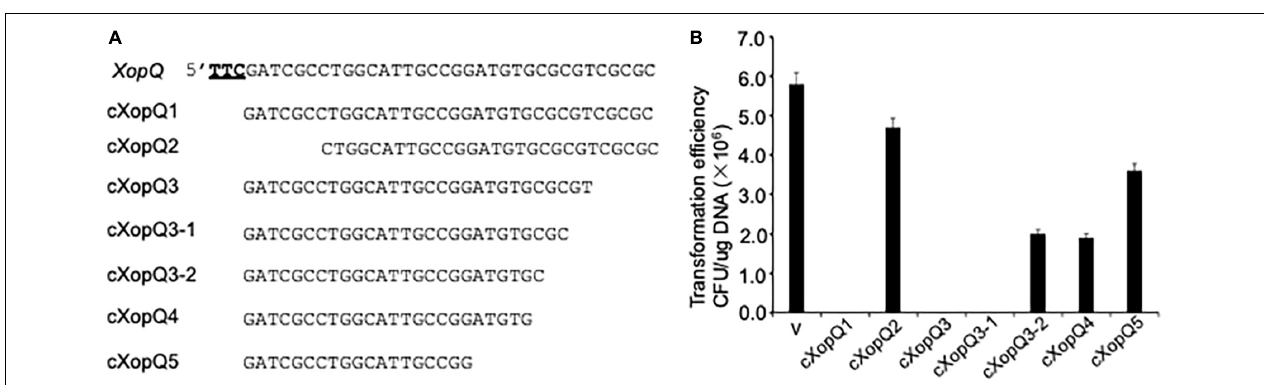
FIGURE 2 | Detection of CRISPR function using various truncated forms of gRNA spacer sequences. (A) gRNA sequence targeting spectinomycin gene as a native version (cXopQ1). Various truncated spacer sequences of gRNA missing either their 5 (cid:48) sequences or their 3 (cid:48) sequences (cXopQ2, cXopQ3, cXopQ3–1, cXopQ3–2, cXopQ4, cXopQ5). The trinucleotide motif TTC, which is the conserved protospacer adjacent motif (PAM), is underlined in bold (XopQ). (B) Functional analysis of the truncated gRNA spacer sequences in PXO99 A cells. Transformation efficiency was measured as CFU per microgram of plasmid DNA. Error bars represent 5%